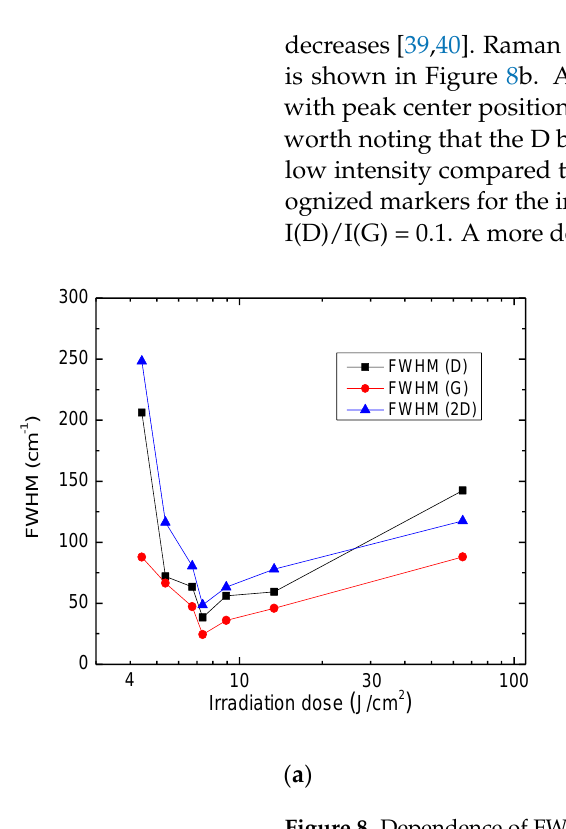
Figure 8. Dependence of FWHM of D, G and 2D bands on the irradiation dose ( a ); Raman spectra of LIG in PI achieved using the 7.34 J/cm 2 irradiation dose ( b ).